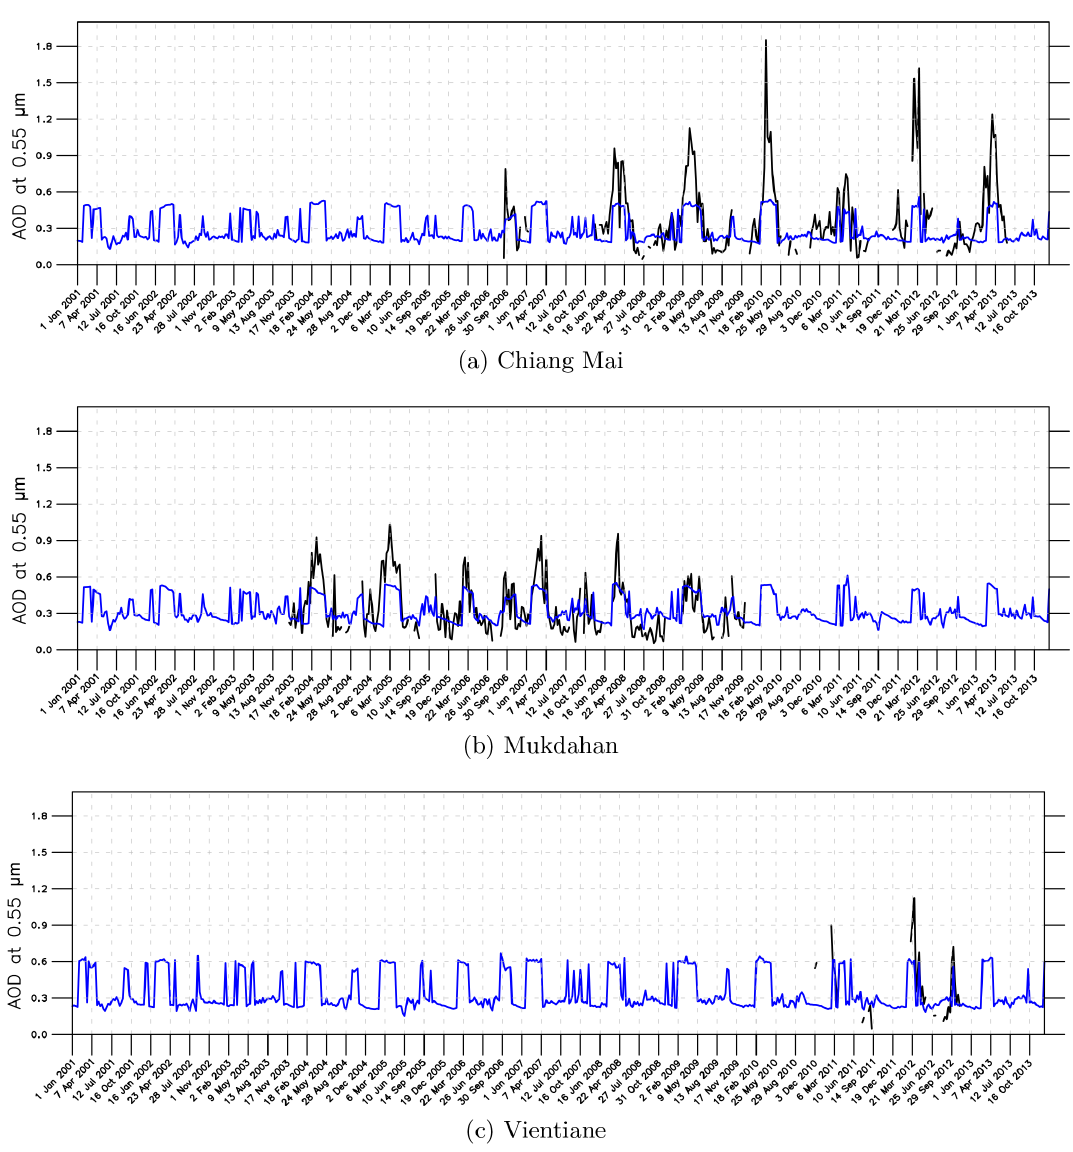
Figure 5. Temporal series of 8-day AERONET AOD (black) and AOD north (blue) at Bac Giang (a1), Nghia Do (b1), Pimai (c1), Ubon Ratchathani (d1), Chiang Mai (a2), Mukdahan (b2), and Vientiane (c2) (2001–2013). All x axes are the time coordinates from January 2001 through December 2013. y axes are the